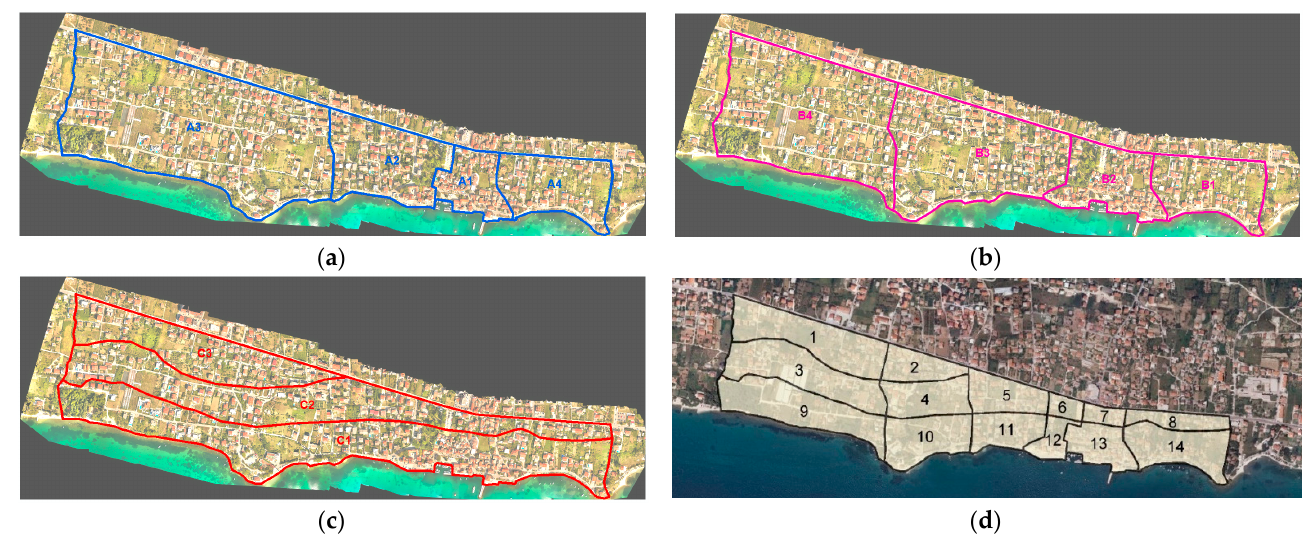
Figure 9. The creation of homogenous zones: ( a ) four areas defined by specific urban characteristics; ( b ) four areas defined by main roads; ( c ) three areas defined by terrain (contours 5 and 10 m); ( d ) intersection of layers resulted with 15 homogenous zones.